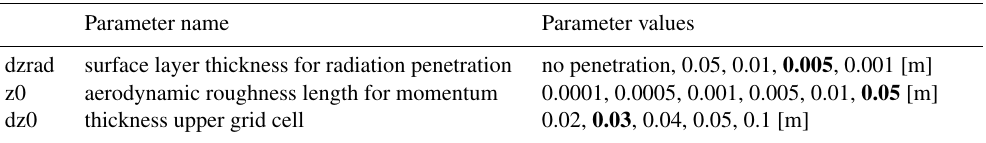
Figure 1. (a) Map of the McMurdo Dry Valleys where the black box shows the region with the Garwood Valley and Joyce Glacier shown in (c) . (b) AWS set-up on Joyce Glacier. Map was made using the Quantarctica QGIS package collated by the Norwegian Polar Institute (https://www.npolar.no/quantarctica/, last access: 12 December 2022). Table 1. Overview of parameter settings used in ensemble simulations with the surface energy and mass balance model. Parameter settings of the reference run are indicated in